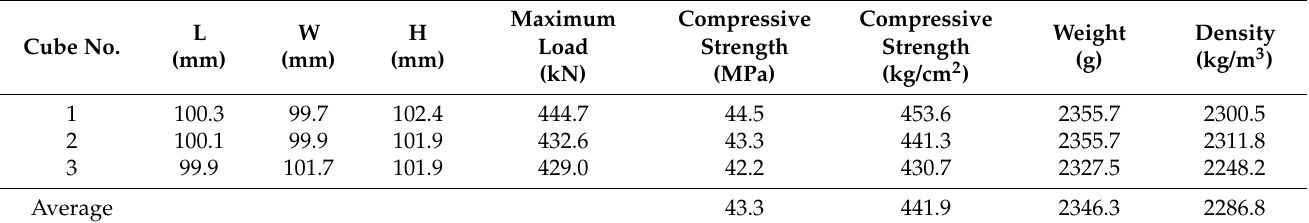
Table 2. The compressive strength and density test results for the